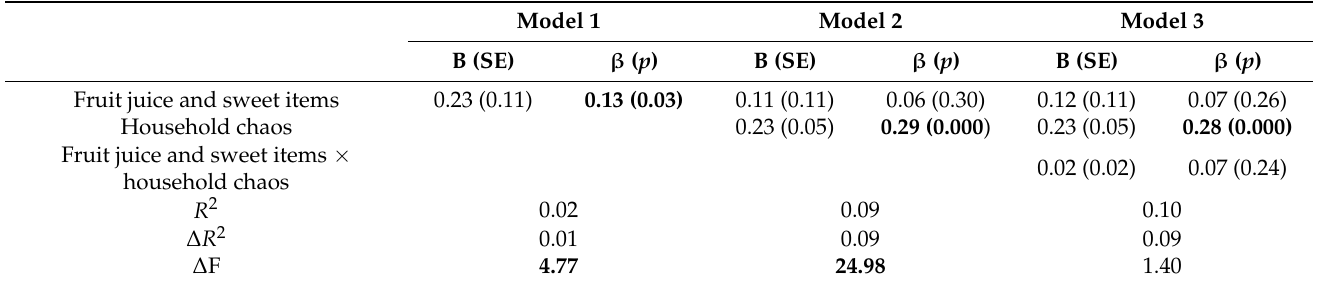
Table 9. Multiple Regression Analyzing Associations Between Fruit Juice and Sweet Items, Household Chaos, and Flexibility Index